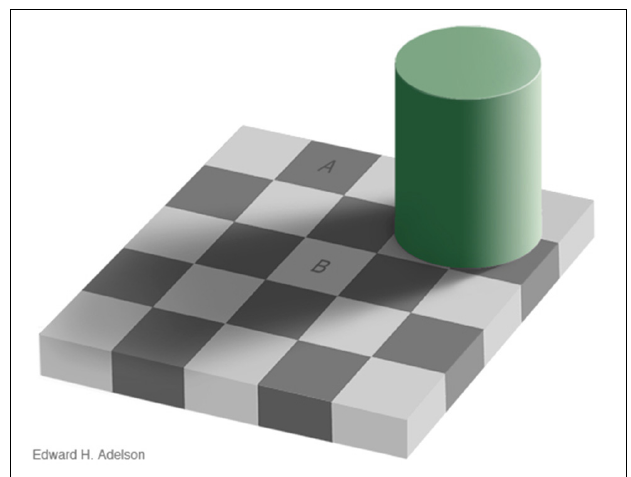
FIGURE 11 | Adelson checker-shadow figure. A and B have the same luminance but A appears as a brightly-lit dark surface, while B appears as a light surface viewed in shadow. Copyright 1995, Edward H. Adelson. Used by permission; http://persci . mit .